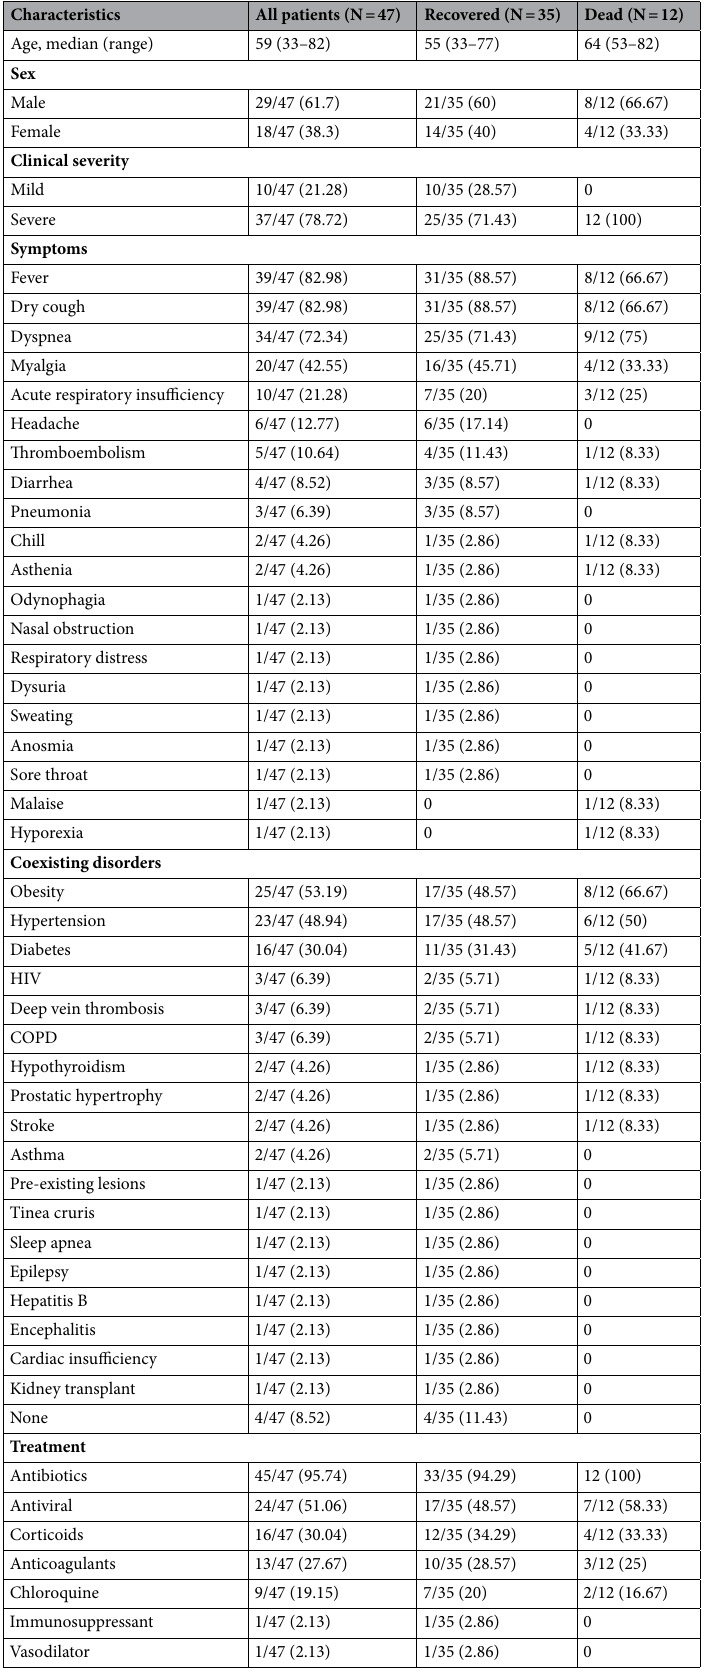
Table 1. Characteristics of 47 enrolled